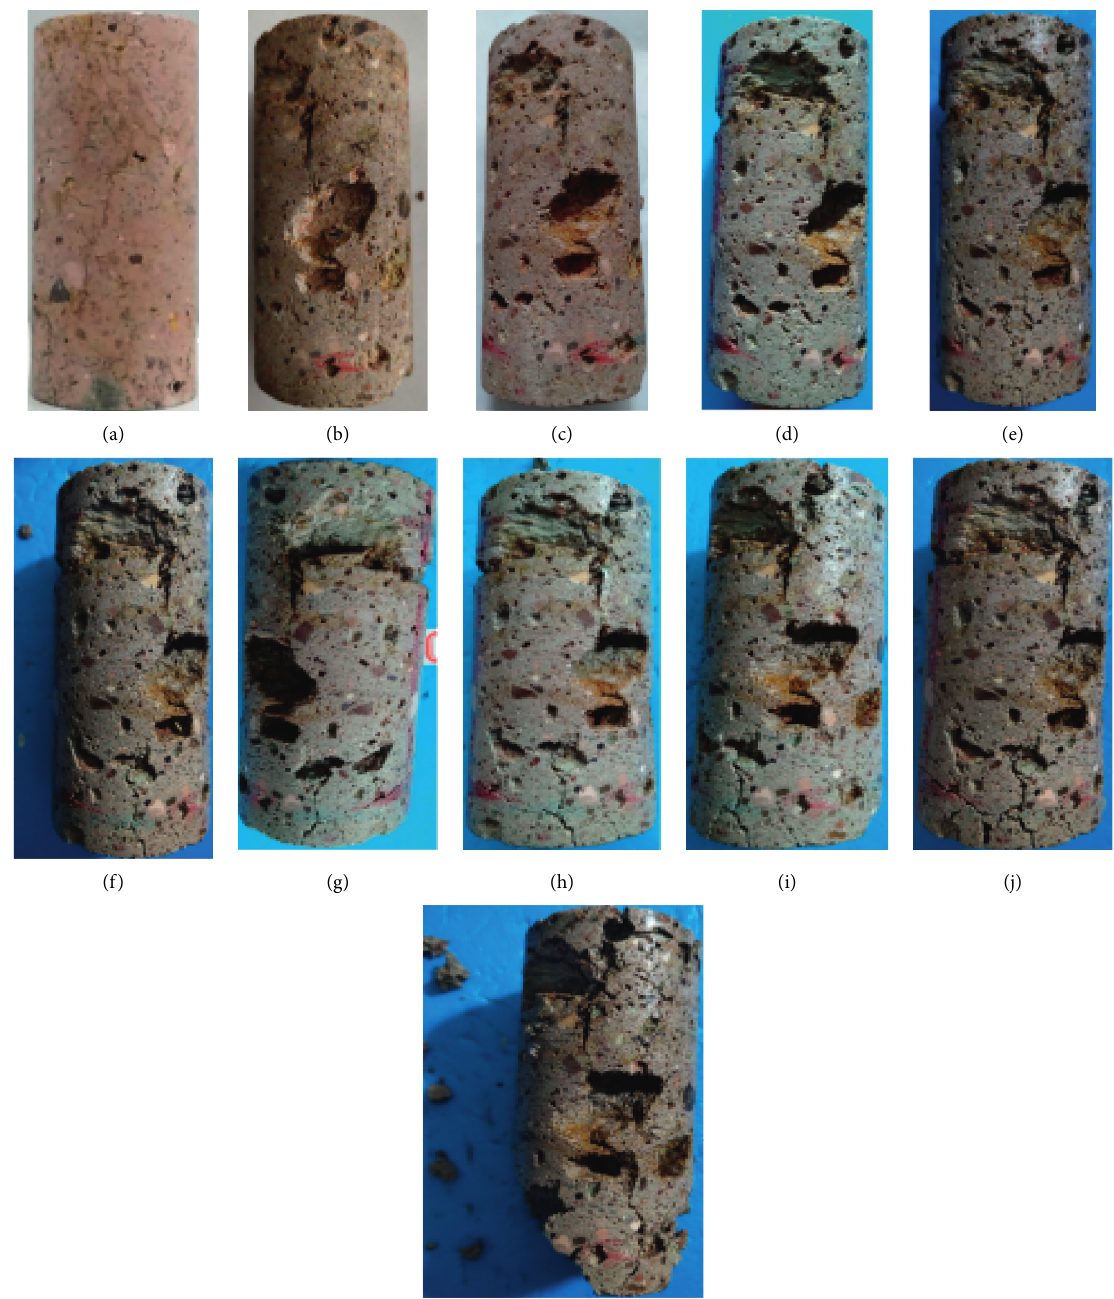
Figure 5: Apparent morphological changes of the representative samples under the freeze-thaw cycles. (a) N � 0. (b) N � 40. (c) N � 50.